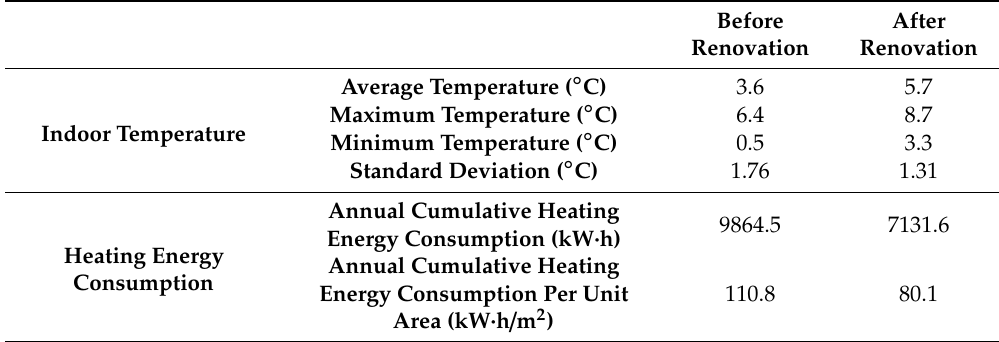
Figure 17. The annual cumulative heating energy consumption before and after renovation of the roof. Table 6. The data comparison of temperature and energy consumption before and after renovation of the